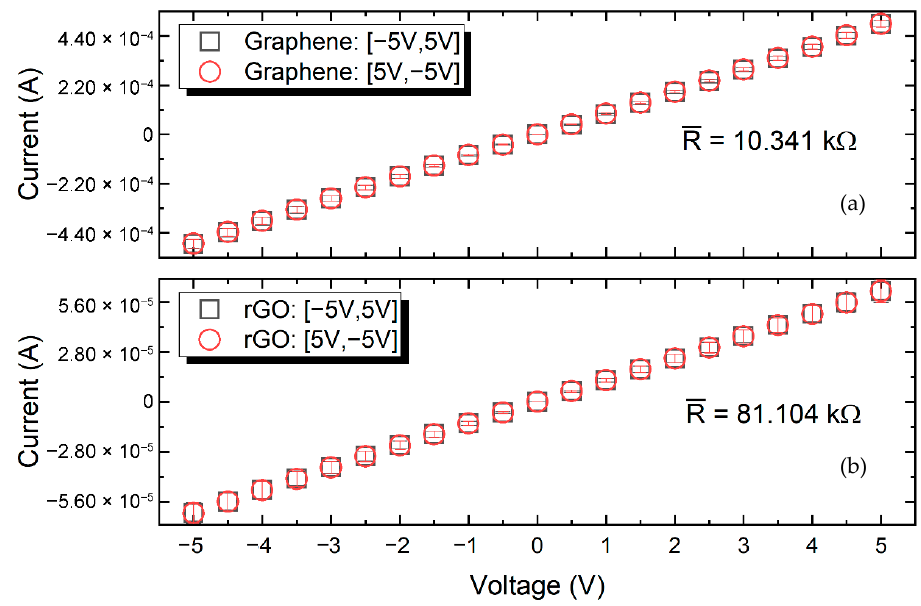
Figure 6. IV curve of inkjet-printed graphene ( a ) and f -rGO ( b ) after annealing at 240 °C. To extract the mean resistivity for each ink, the topological data alongside the elec- trical resistance measurements were combined using Equation (1).